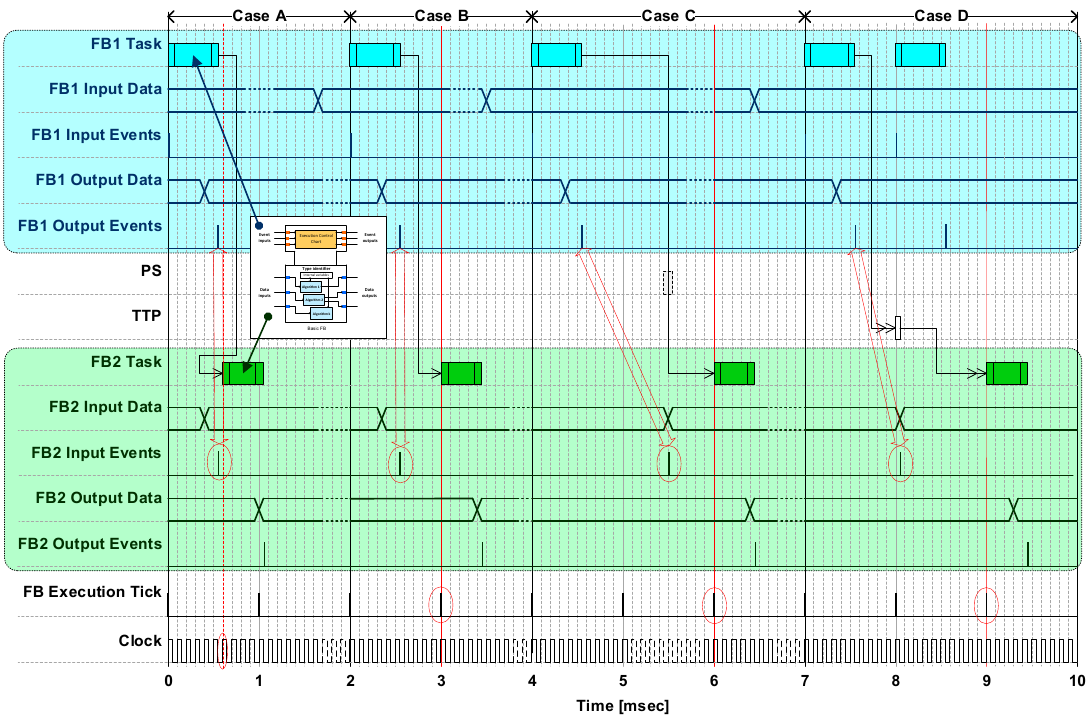
Figure 14. Examples of executions of Function Blocks (FBs) according to the scheduling approaches.